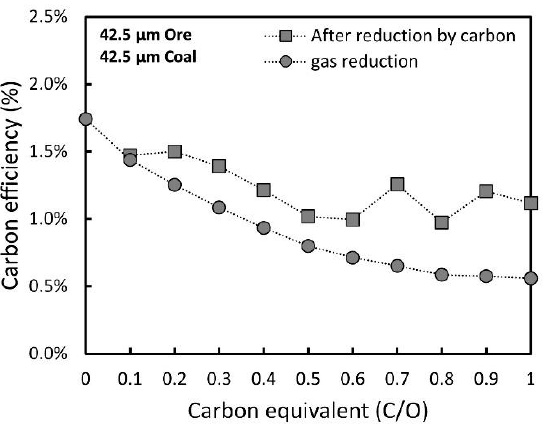
Figure 8. Changes in carbon efficiency of CO gas reduction with different carbon equivalents.